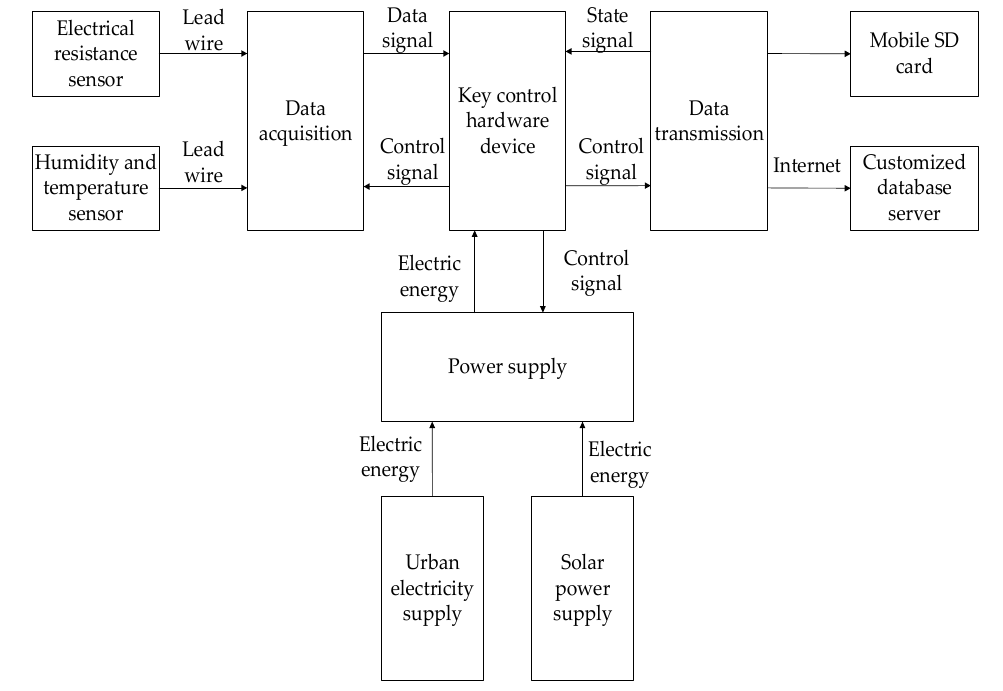
Figure 3. The block diagram of IoT ACM.